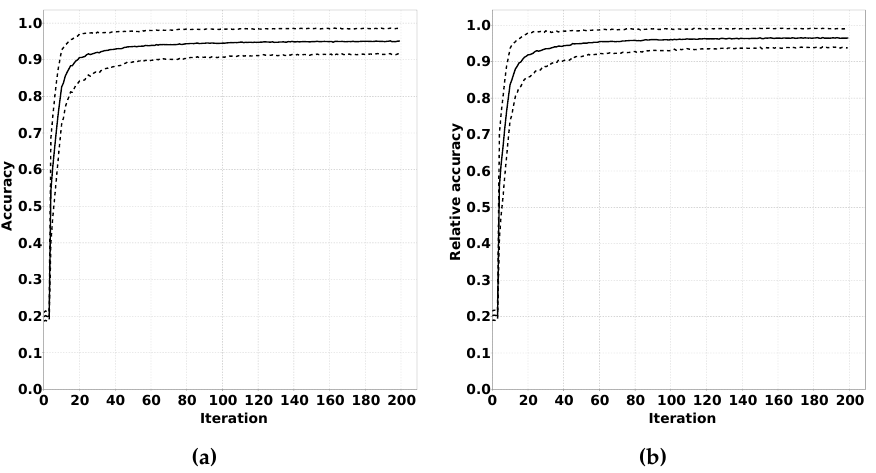
Figure 10. Evolution of accuracy of QUEST classifiers during the online phase with over 200 samples. ( a ) Absolute accuracy; ( b ) Relative accuracy.